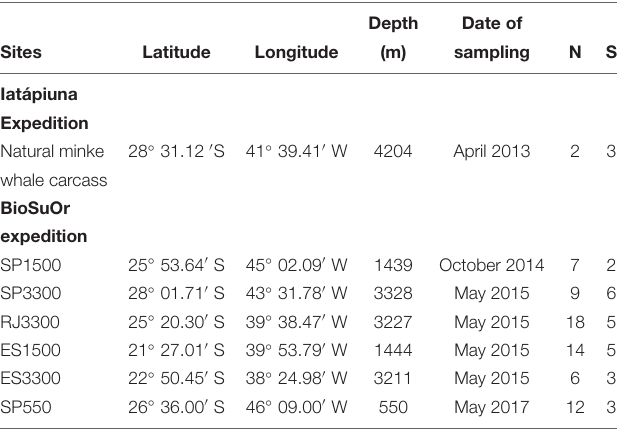
TABLE 1 | Sampling station of natural whale-fall (Iatá-Piuna Expedition) and lander deployment (BioSuOr project).